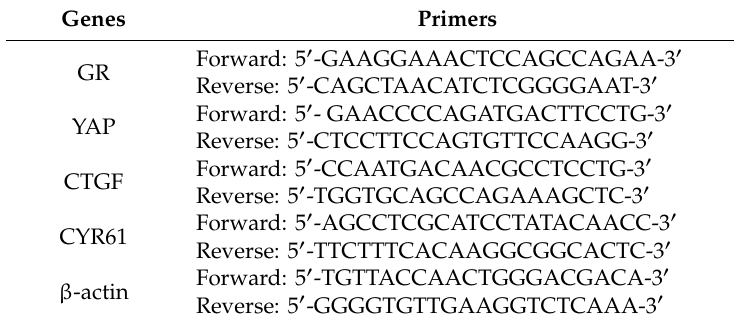
Table 1. Specific Real-time RT-qPCR primer sequences containing human GR, YAP, CTGF, CYR61, and β -actin